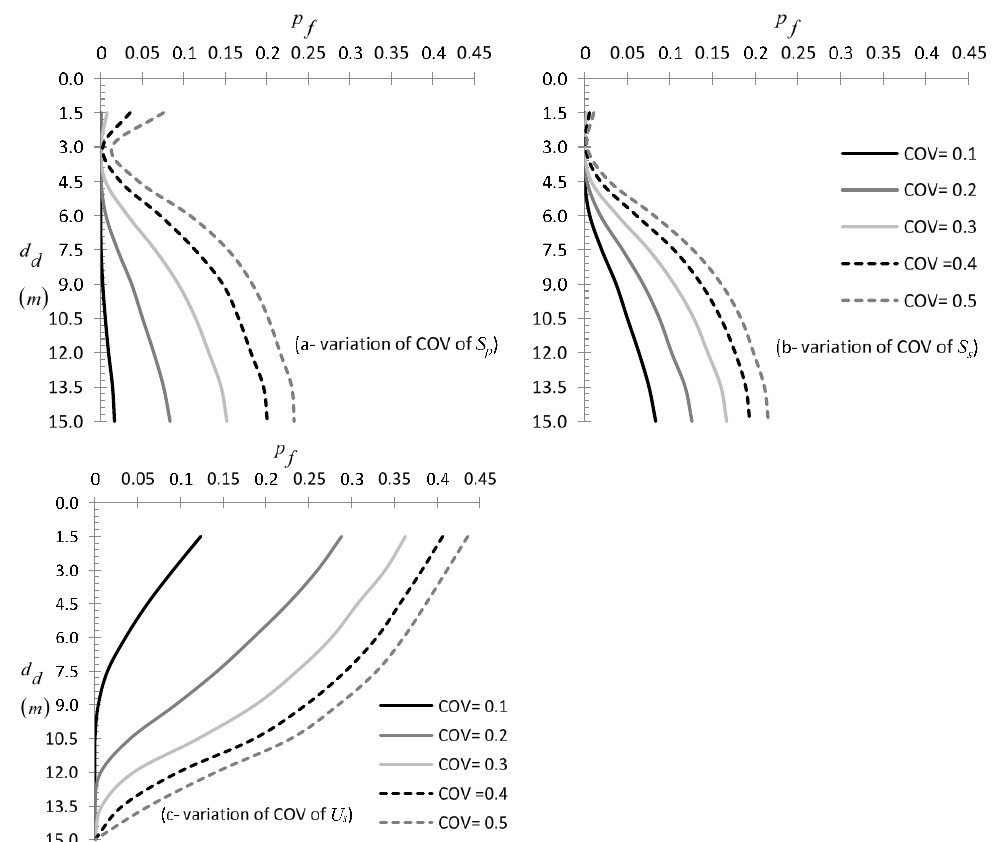
Figure 9. p f vs. d d curves for di ff erent values of COV values of ( a ) S p , ( b ) S s , and ( c ) U s Figures ( a ) and ( b ) refer to the SLS state, whilst figure ( c ) refers to the ULS state; θ / L = 2 / 3 in all